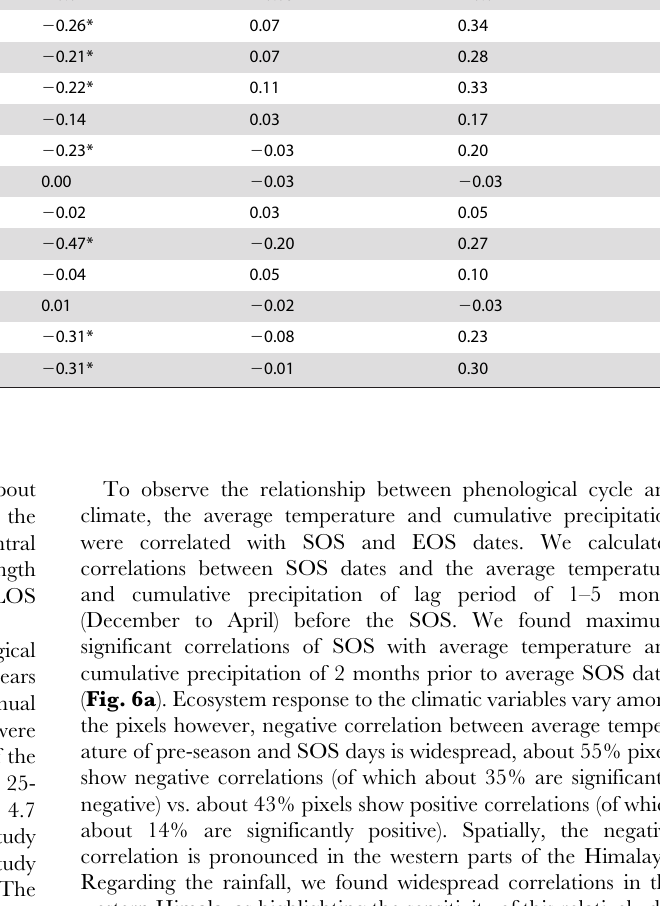
Table 1. Linear trends of area-averaged phenological parameters (SOS, EOS and LOS) in different ecoregions of the Himalayas.